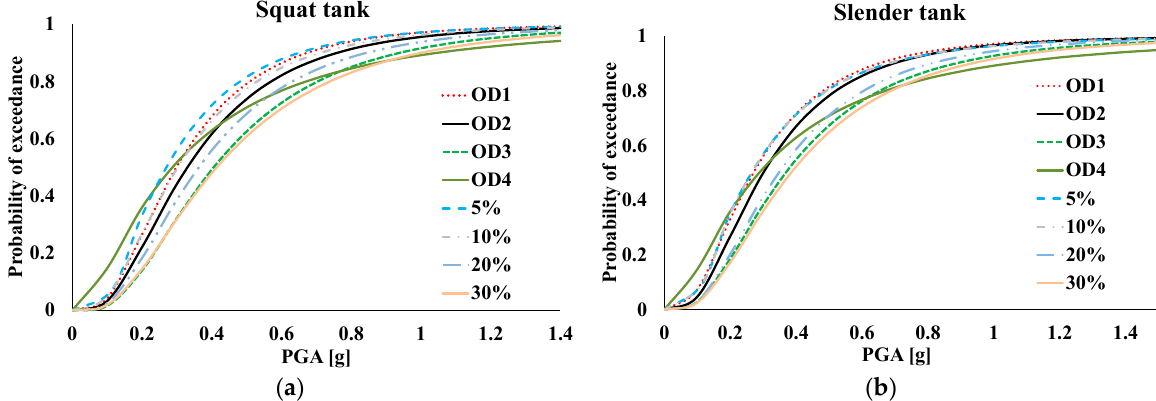
Figure 4. Three- and two-dimensional representations of Pareto front results regarding MOGA1 formulation for: ( a ) the squat and ( b ) slender tank.